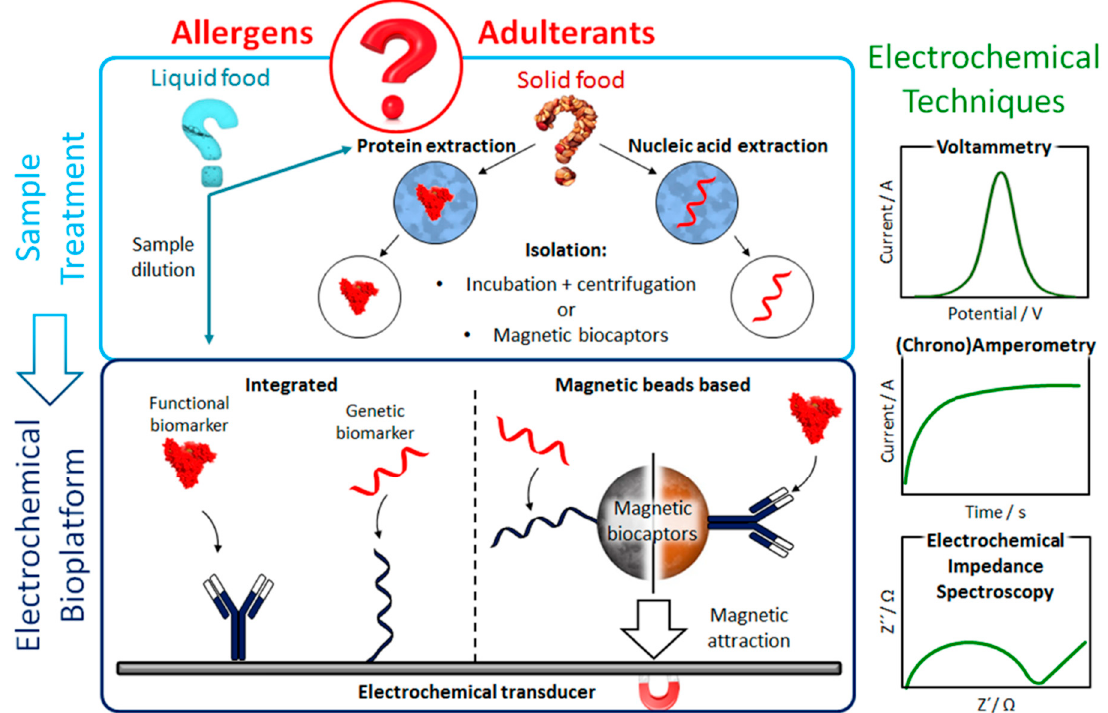
Figure 1. Schematic display of the fundamentals (target biomarker extraction and electrochemical detection) involved in the construction of electrochemical biosensors for the determination of food allergens and adulterants at genetic or functional level using integrated or magnetic beads (MBs)-based